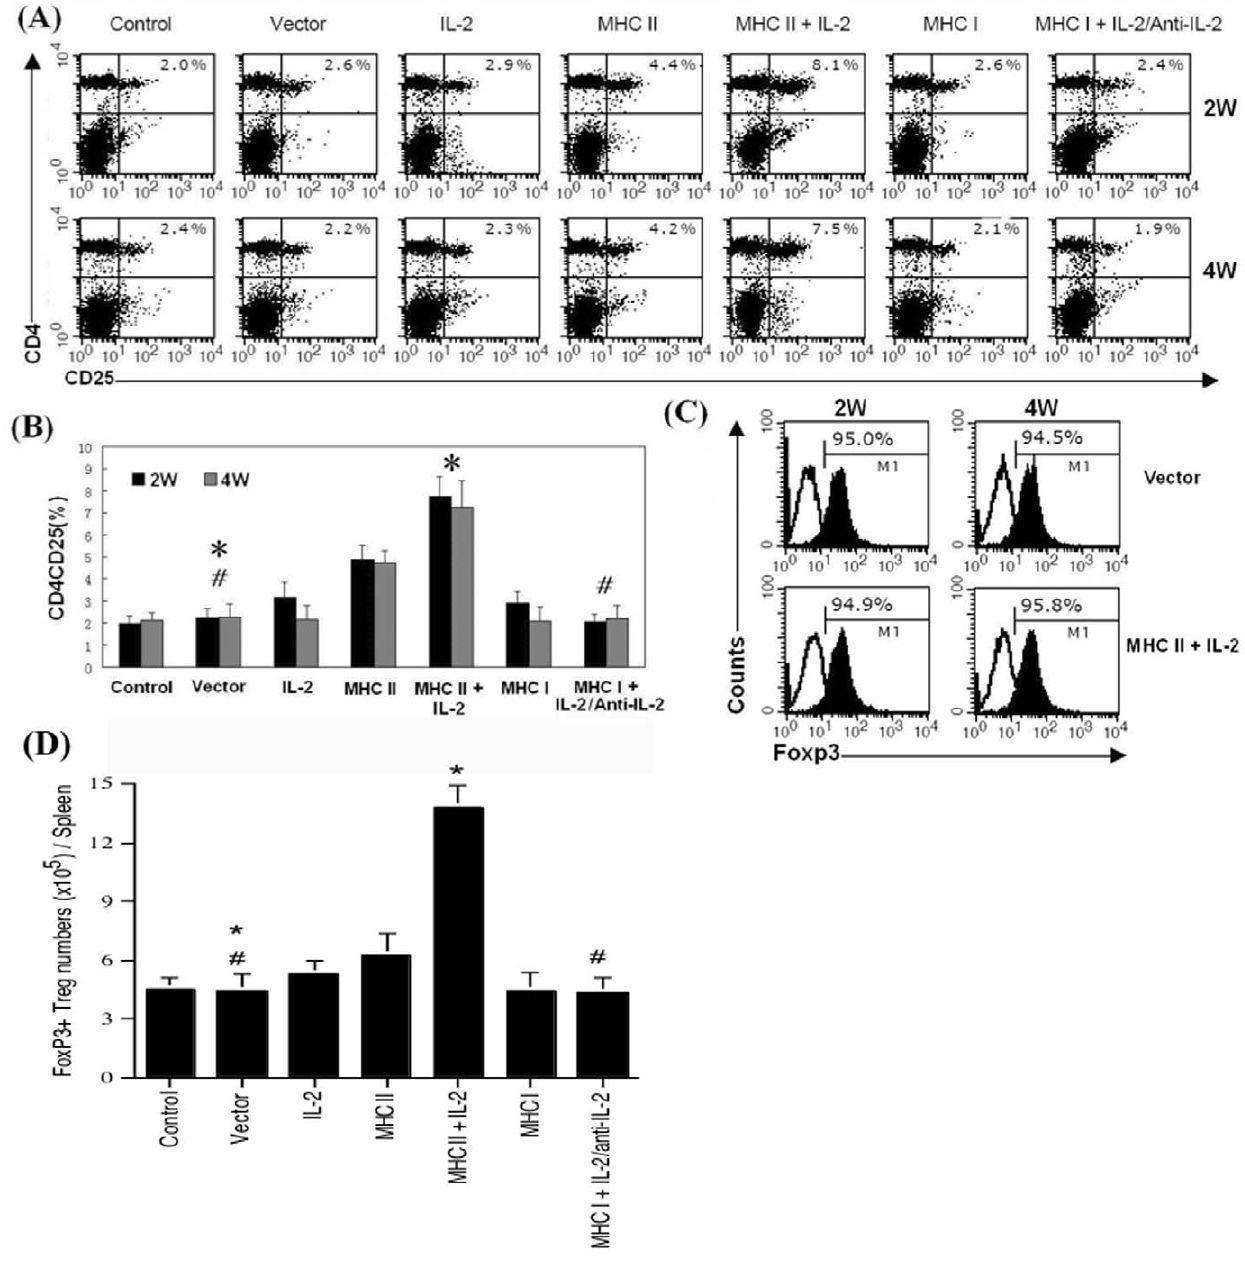
Figure 3. Donor MHC II DNA vaccination and administration of IL-2 prior to transplantation induce FoxP3 + Treg cells. B6 mice were treated with recombinant IL-2 alone, anti-IL-2 alone, immunization with vector, MHC I or MHC II alone, or both IL-2 regimen and donor MHC DNA vaccination in recipients as indicated. Two and four weeks after secondary immunization, spleen cells were stained for CD4, CD8 and FoxP3 expression and analyzed by FACS. ( A ). Density plot is shown for the percentage of CD4 + CD25 + Treg cells from one representative experiment. ( B ). Data are presented as mean 6 SEM and represent an average of three independent experiments (*P , 0.05 and # P . 0.05). ( C ). Histograms shown are percentages of FoxP3 + cells after gating on CD4 + CD25 + cells from control group. One representative of three experiments is shown. ( D ). The absolute numbers of FoxP3 + Treg cells per spleen two weeks after final immunization were also calculated (*P , 0.05 and # P . 0.05).